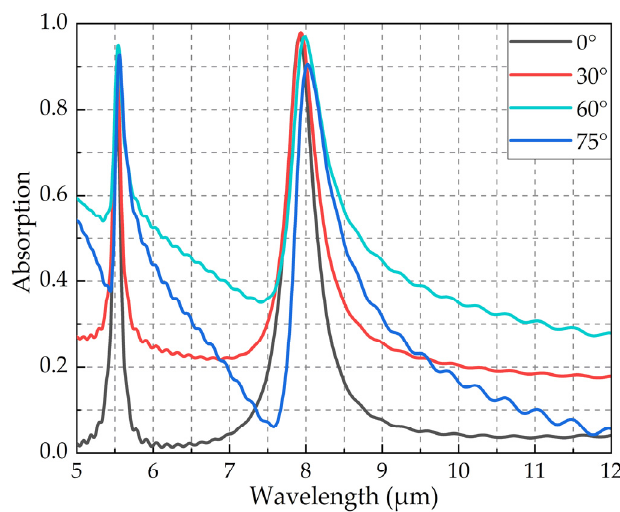
Figure 9. Simulated absorption spectra of the cross-shaped aperture absorber for: ( a ) Different polarization angles; ( b ) different l a . Electronics 2020 , 9 , x FOR PEER REVIEW 9 of 14